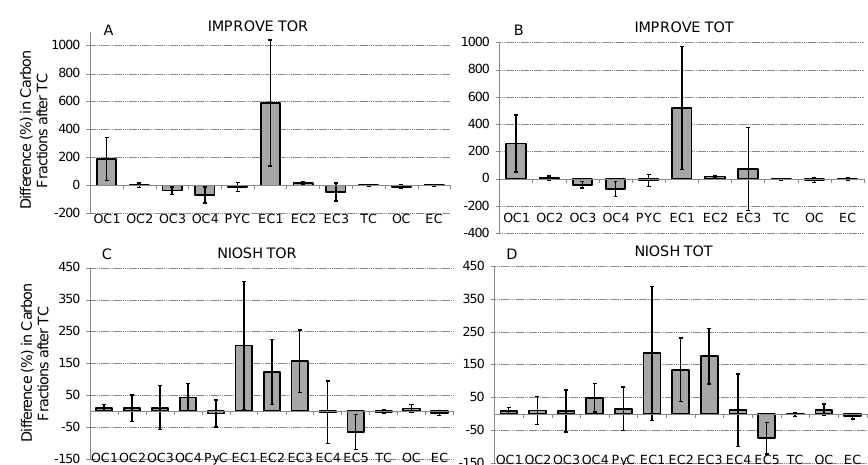
Figure 2. Percent difference ( (y − x) 100 % /x ) and standard deviation in carbon fractions and sub-fractions of the results after temperature calibration for the (a) IMPROVE TOR, (b) IMPROVE TOT, (c) NIOSH TOR, and (d) NIOSH TOT temperature